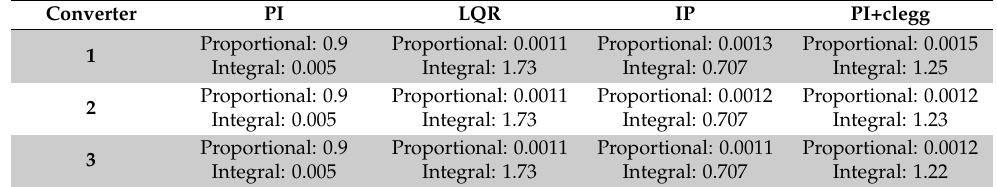
Table A2 shows the control parameters used in this work. Table A2. Controller